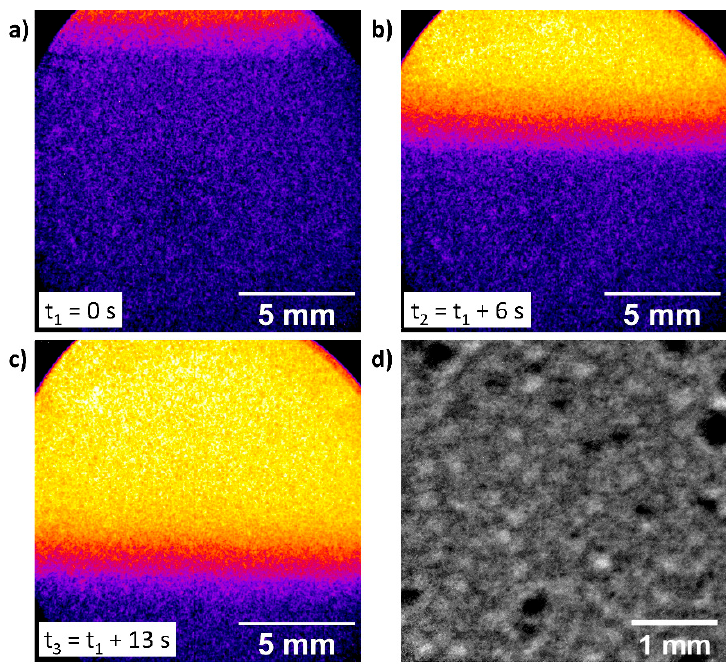
Figure 8. ( a – c ) Neutron radiography of pumping process in 2 nd Gen. cell; ( d ) in-operando neutron radiography image of ODC.